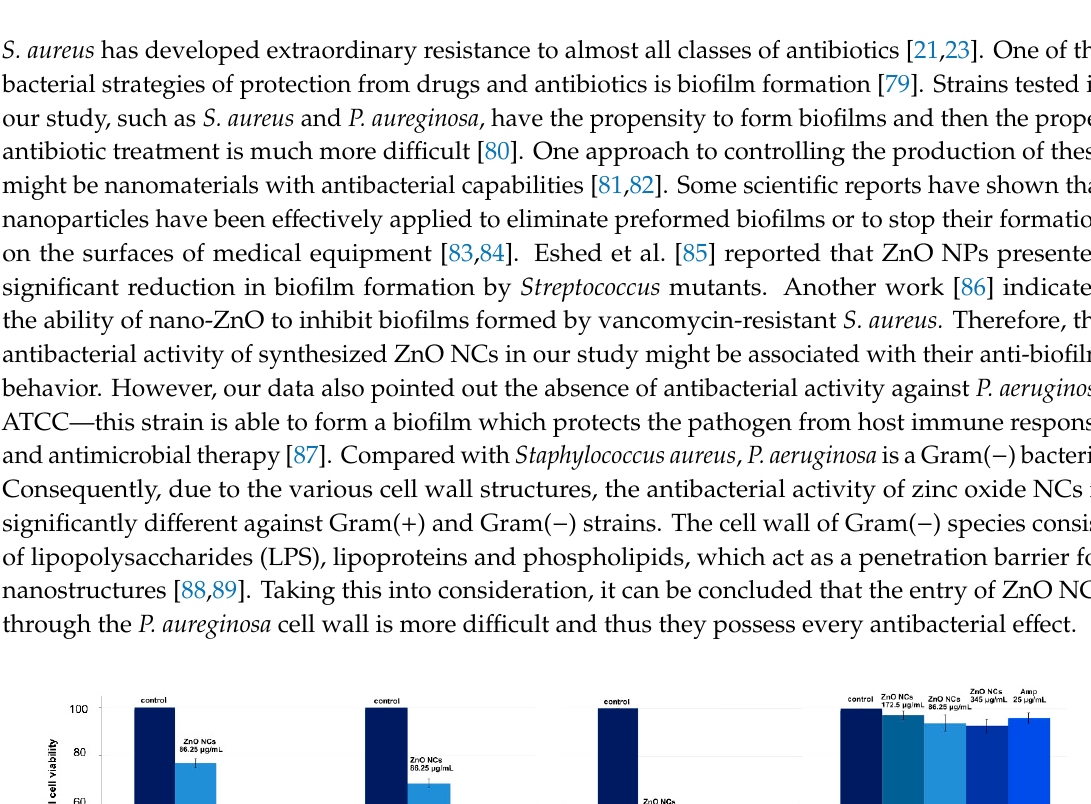
Table 1. Minimum inhibitory concentration (MIC) of the biologically synthesized ZnO NCs against tested microorganisms.